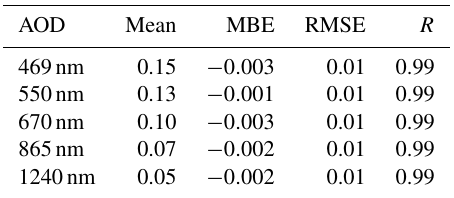
Table D1. Comparison of AOD provided by CAMS RA as refer- ence and calculated with T–CARS from the CAMS RA model level aerosol mass mixing ratio. The data are acquired in the period from 2003 to 2019 for